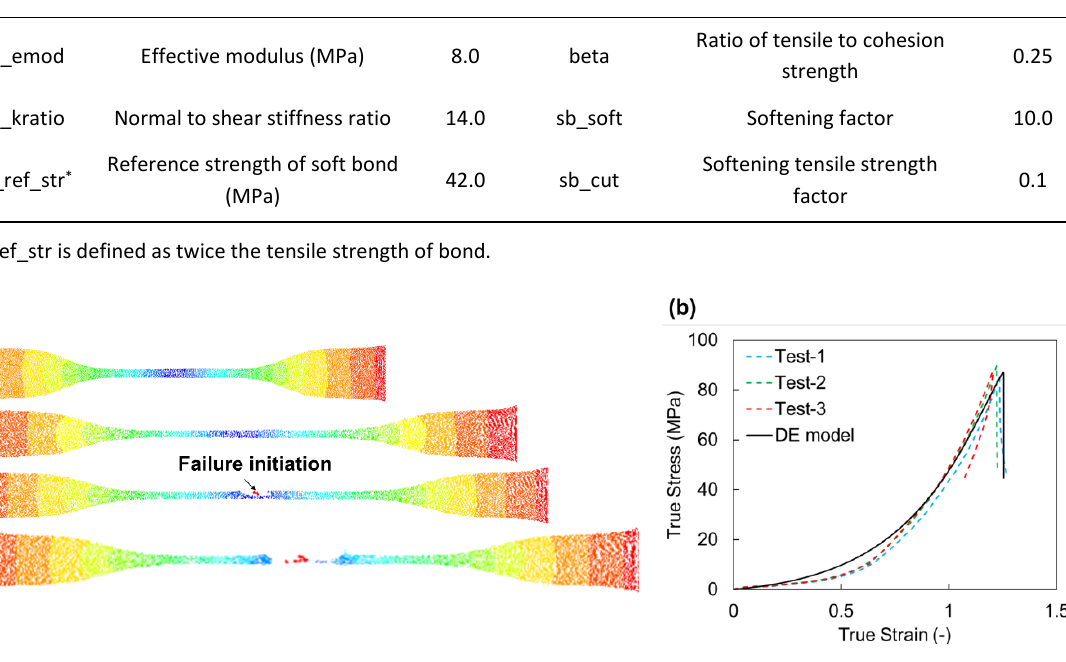
Fig. 2: Large deformation of UT numerical model and results validation. a) Tensile deformation and failure of numerical specimen. b) Validation on the true stress-strain relationships of PVB